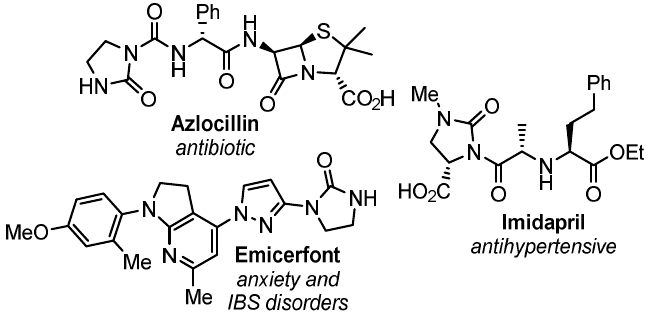
Figure 1. Some known drugs possessing imidazolidin-2-one moiety.